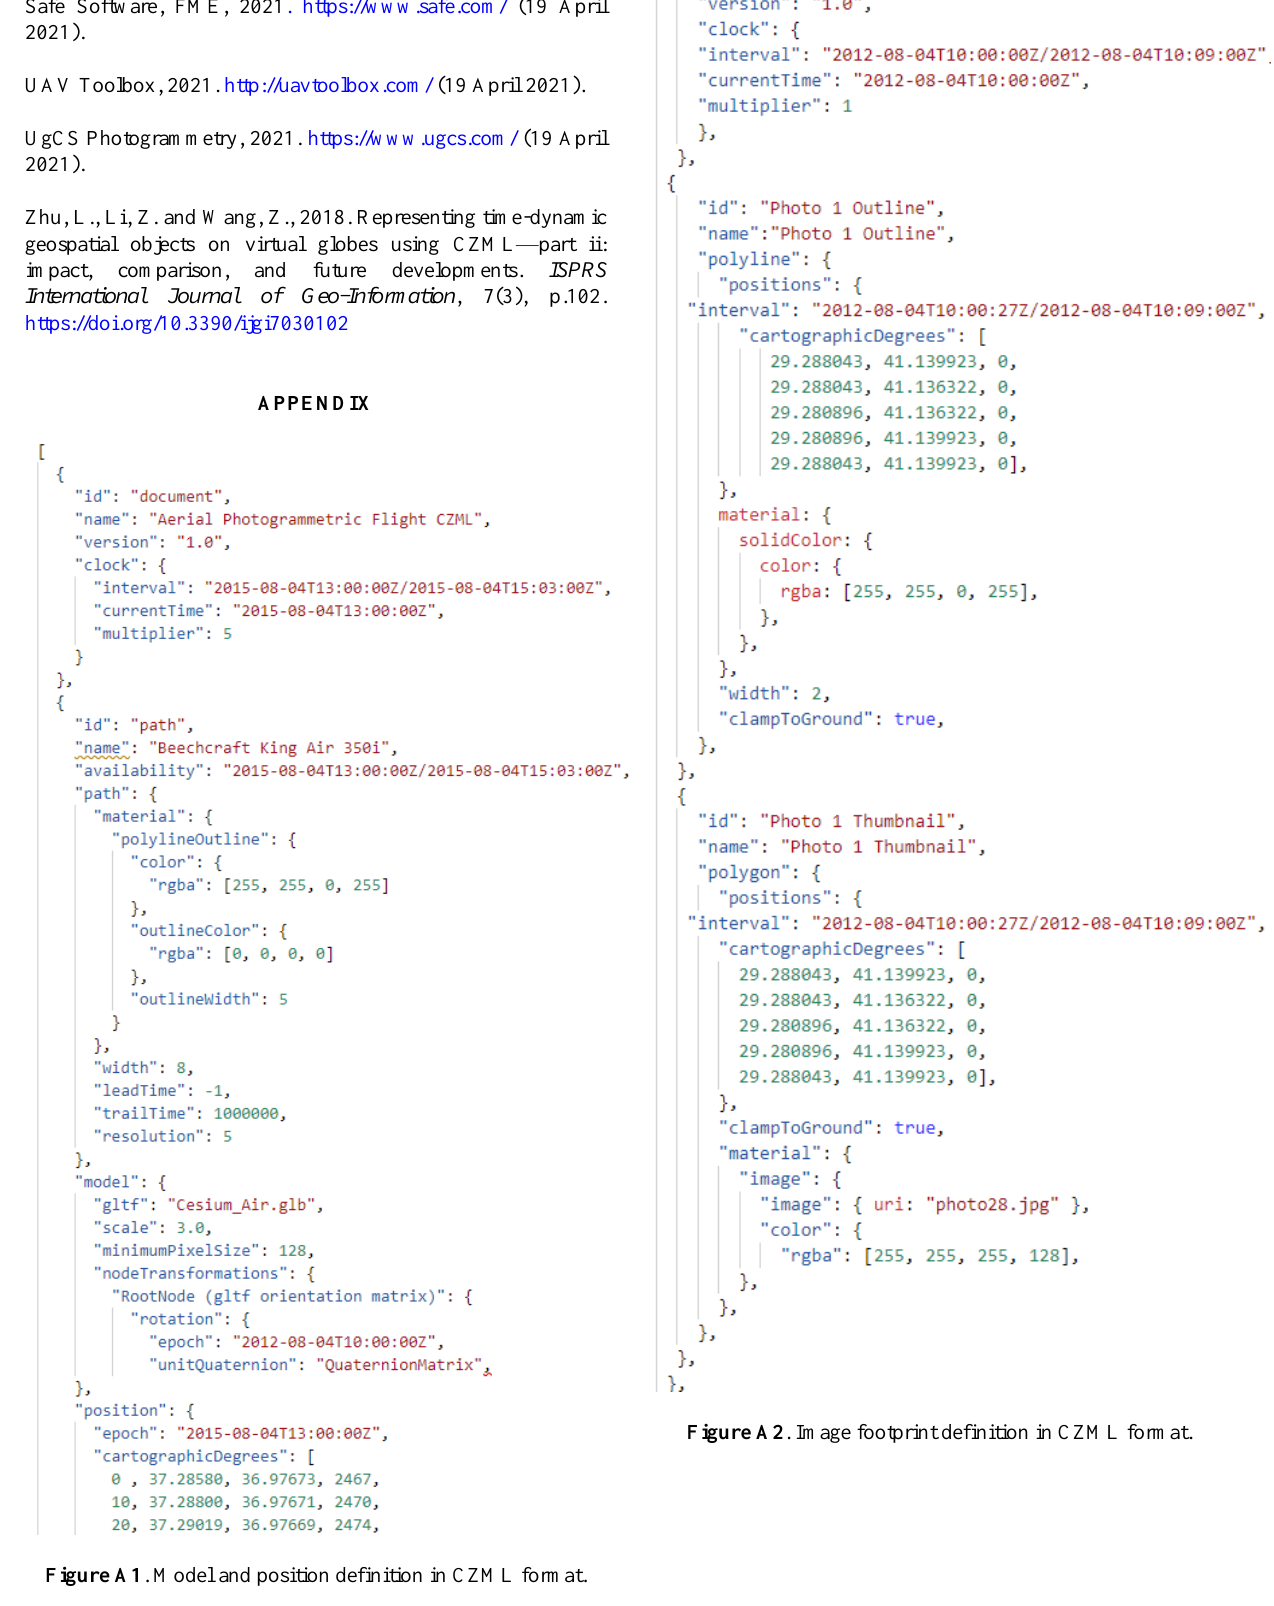
Figure A1 . Model and position definition in CZML format.